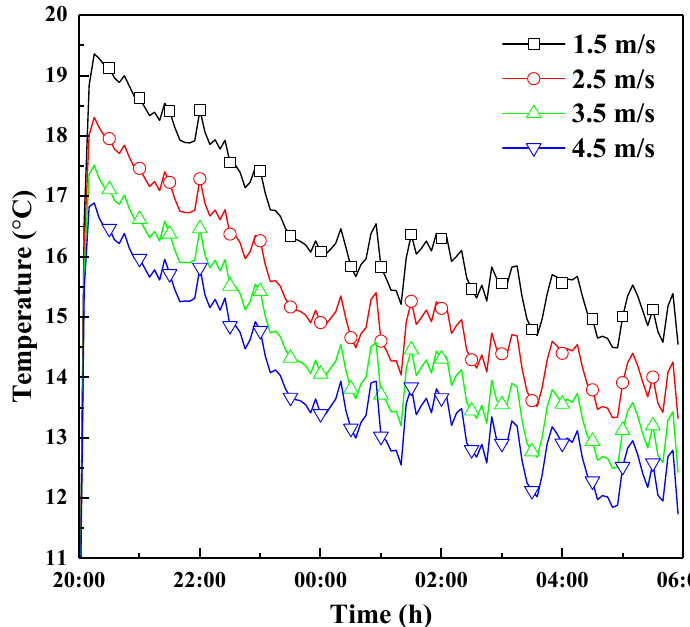
Figure 14. Time-dependent variation of the component surface temperature with different wind speeds.